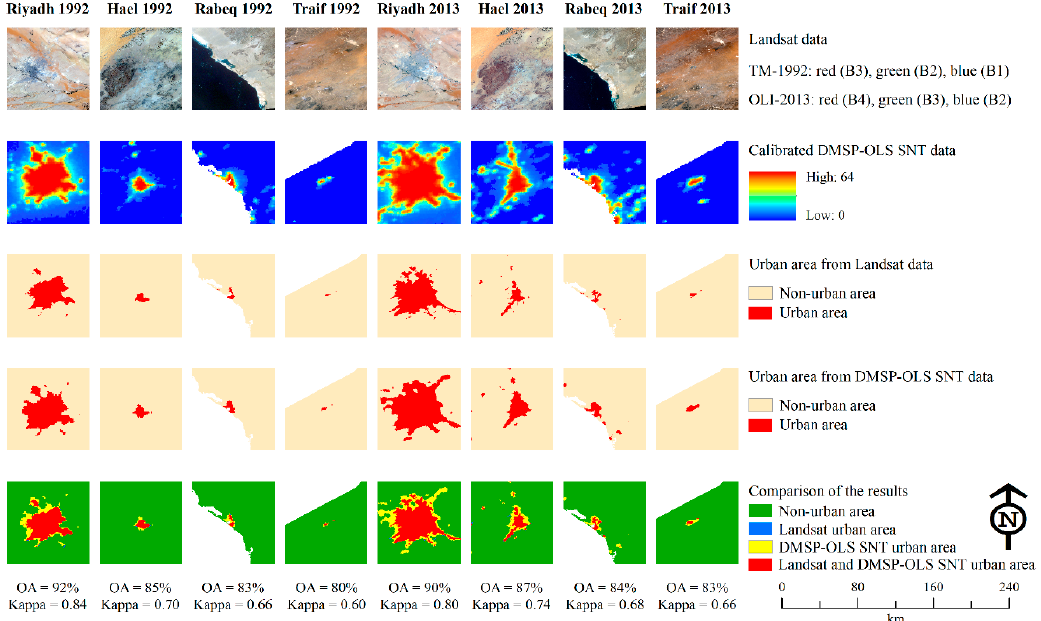
Figure 10. Accuracy assessment of the DMSP-OLS SNT urban areas for representative cities in Saudi Arabia in 1992 and 2013.